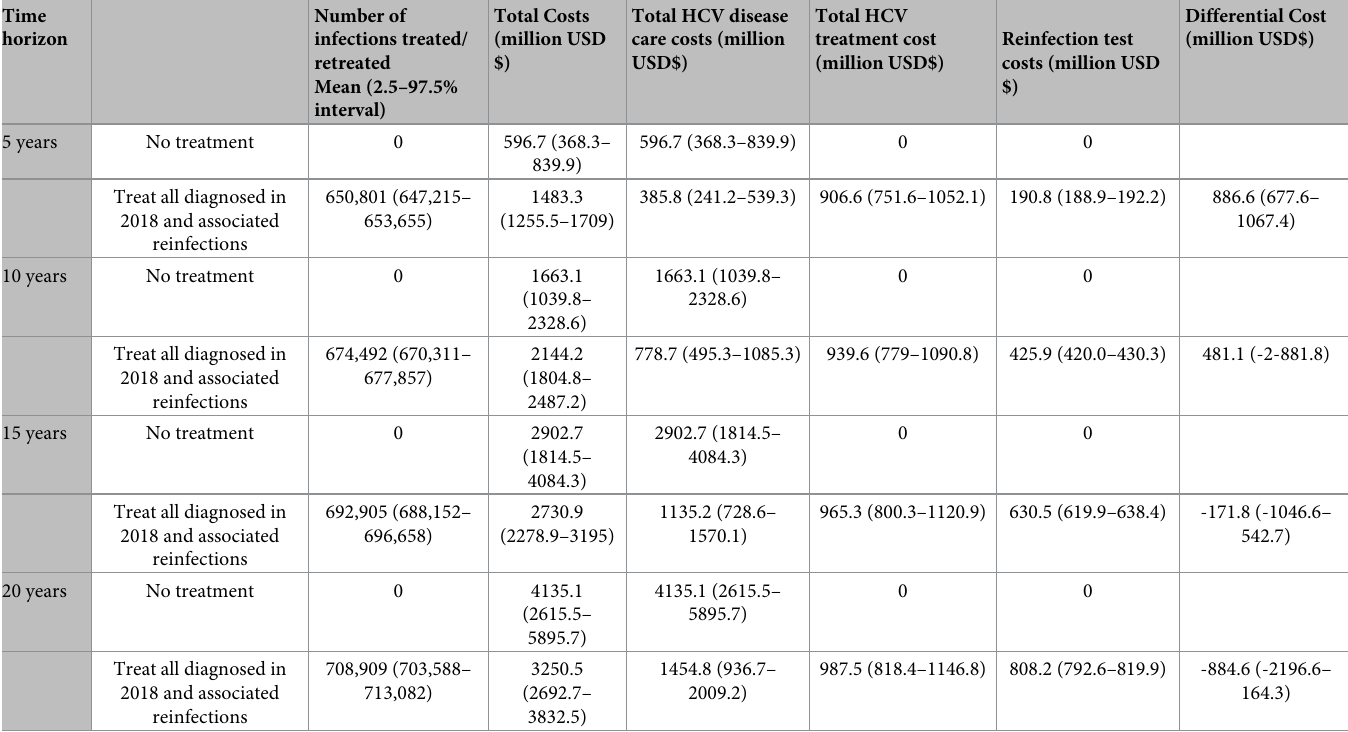
Table 3. Budgetary impact of treating all HCV diagnosed individuals in 2018 for various time horizons, assuming 10% of the HCV infected population is diagnosed. Time